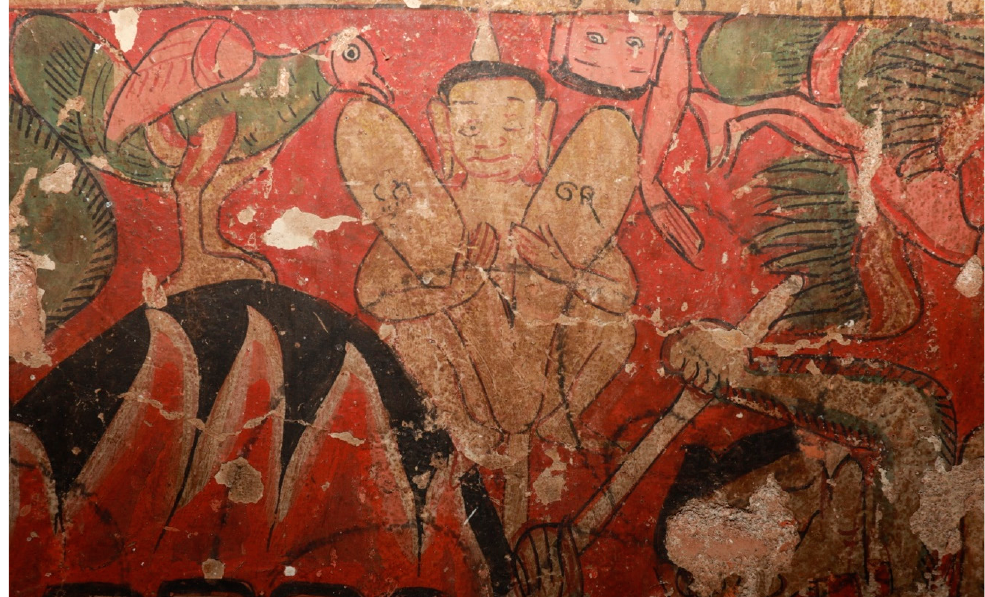
Figure 51. Anaint, Endowment 69, 18th century. Punishment for pleaders.